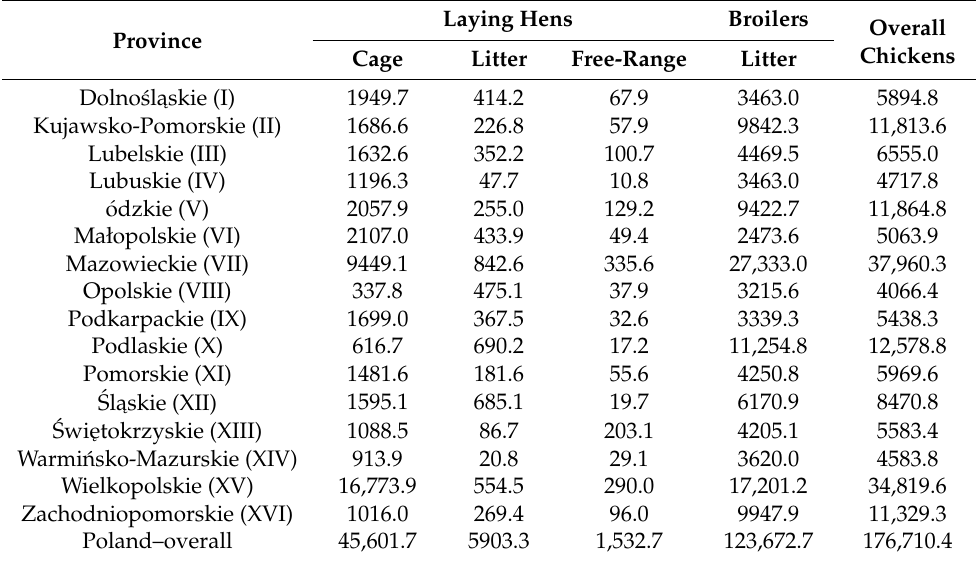
Table 1. Population of chicken in Poland and its provinces according to the rearing system, as of